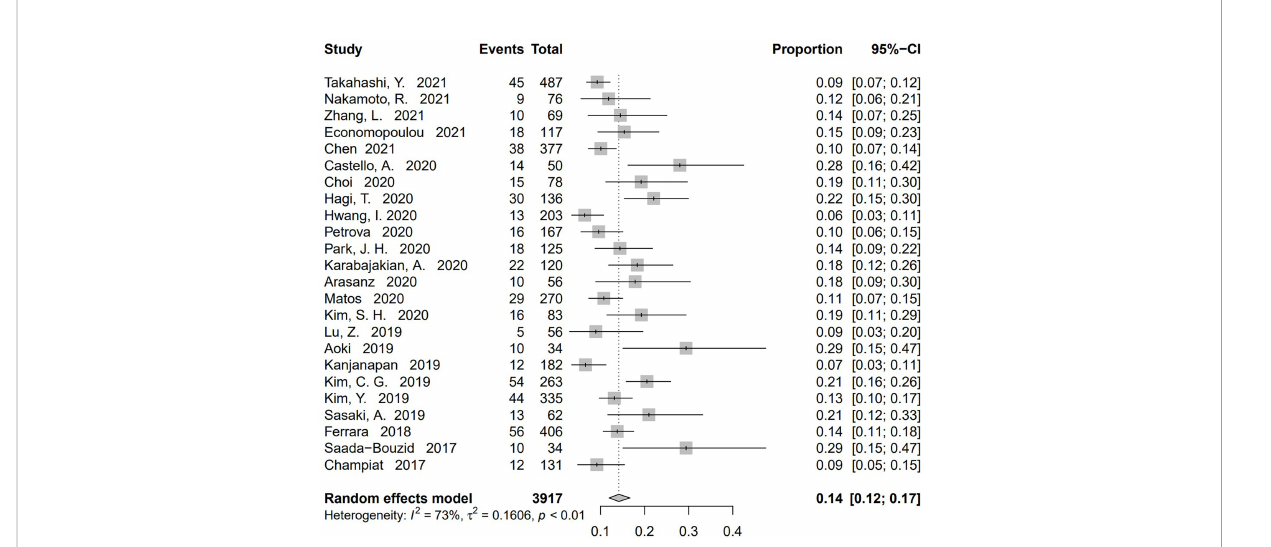
FIGURE 7 Sensitivity analysis of pooled incidence of hyperprogressive disease in the studies with Newcastle – Ottawa scale (NOS) ≥ 7 via “ leave-one-out ” method. The “ Study ” column refers to the study omitted in each time of analysis. CI, con fi dence